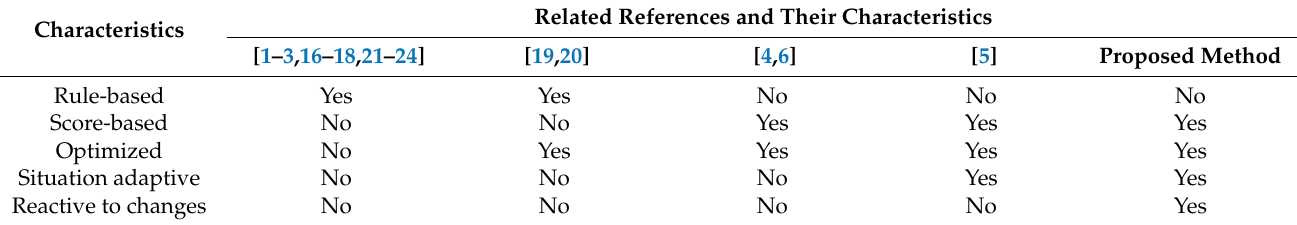
Table 1. Comparison of the proposed method with the related works that determine the stacking locations for individual